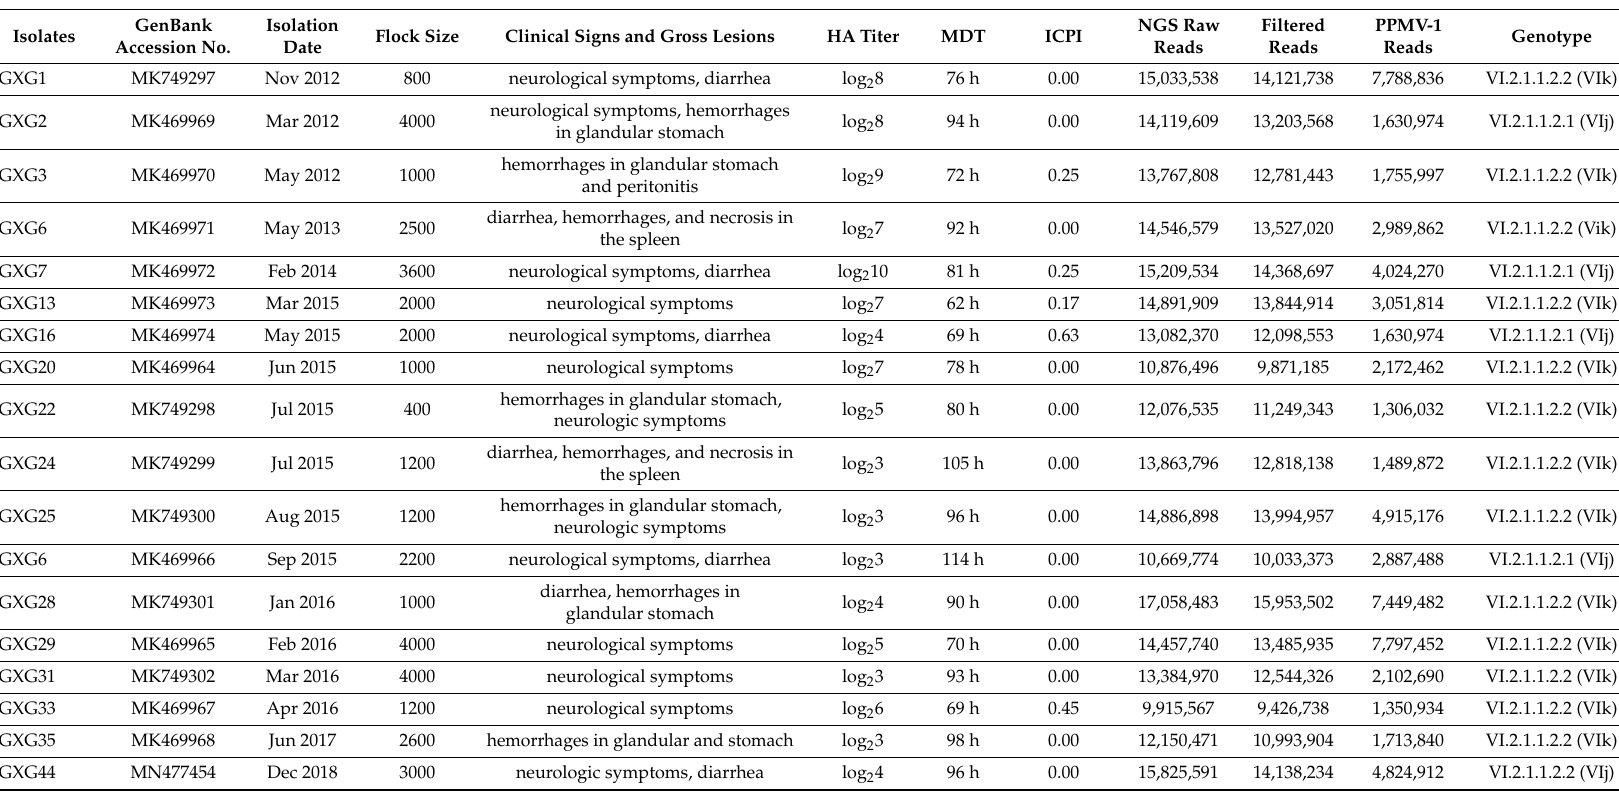
Table 1. Details of the pigeon paramyxoviruses 1 (PPMV-1) samples isolated in this study. HA, hemagglutination assay; MDT, mean death time; ICPI, intracerebral pathogenicity index; NGS, next-generation